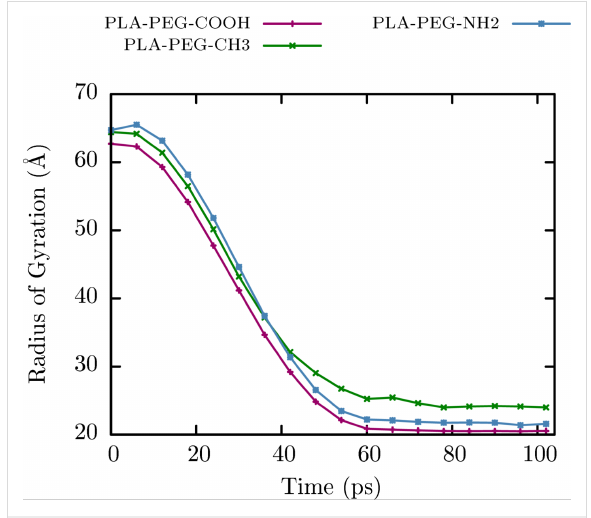
Figure 8: Radius of gyration as a function of time for anionic (PLA–PEG–COOH), neutral (PLA–PEG–CH 3 ) and cationic (PLA–PEG–NH 2 ) nanoparticles.